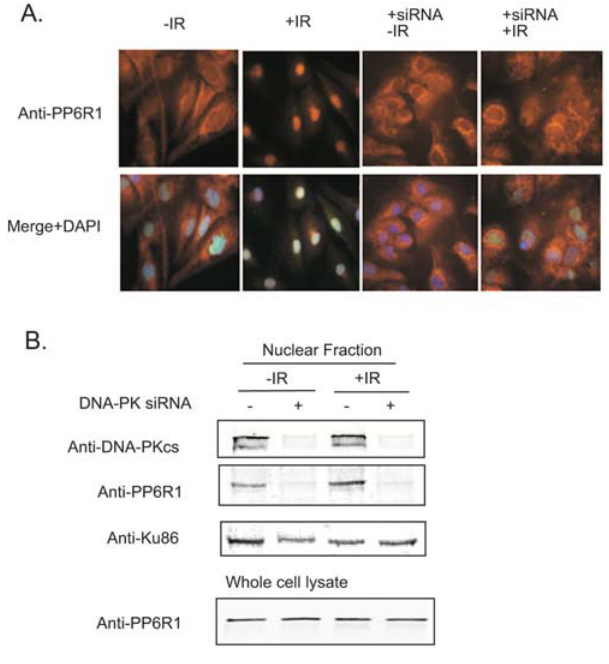
Figure 3. siRNA knockdown of DNA-PKcs abrogates IR-induced PP6R1 nuclear localization. A. M059K cells were transfected with control siRNA or anti-DNA-PKcs siRNA, and 48 hours later subjected to 5 Gy. One hour post-irradiation, the cells were fixed and immunostained with anti-DNA-PKcs and PP6R1 antibodies. Upper row: orange PP6R1 and lower row: merged Dapi ,DNA-PK and PP6R1. B. M059K cells were transfected with control siRNA or anti-DNA-PKcs siRNA and subjected to irradiation 48 hours post –transfection. One hour post-irradiation the cells were fractionated into cytoplasmic and nuclear fractions. The protein levels of DNA-PKcs, PP6R1, and Ku were detected by immunoblotting.